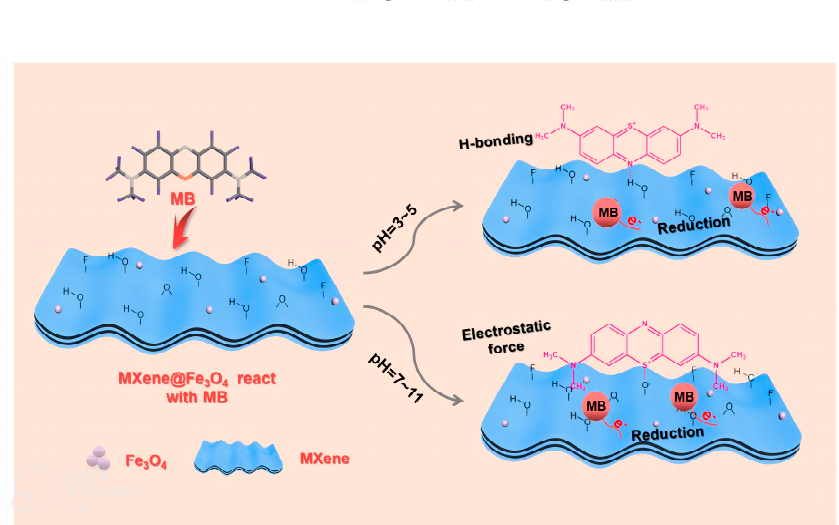
Figure 6. Suggested mechanism for MB adsorption by MXene@Fe 3 O 4 [154].